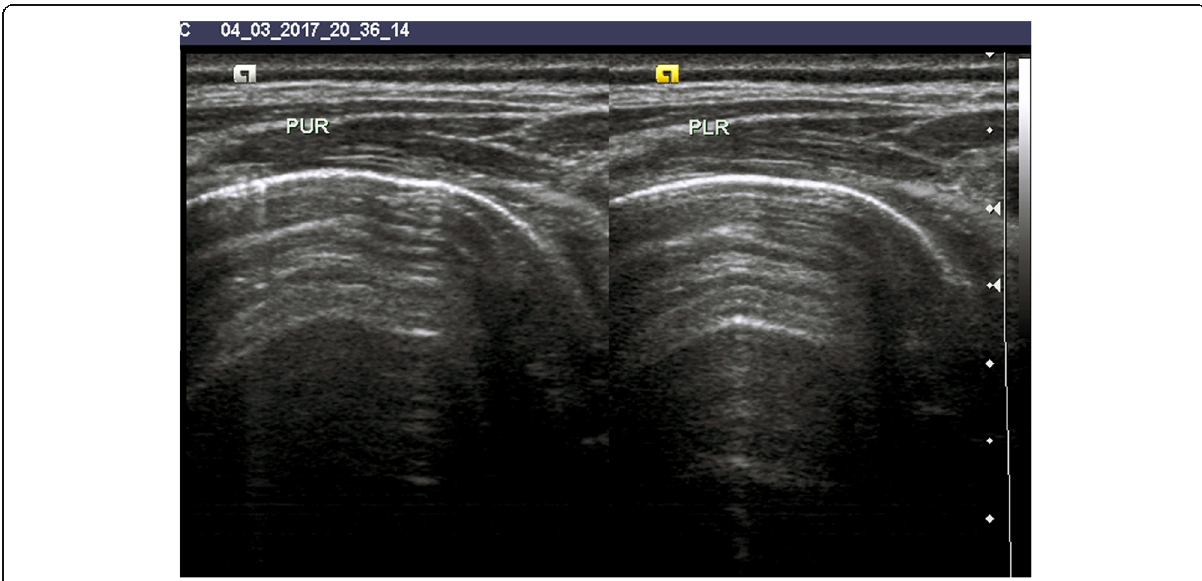
Fig. 5 B-mode ultrasound in the same patient before extubation and after switching to synchronized intermittent mechanical ventilation SIMV. Scanning of the posterior upper and lower zones of the right lung showed improvement of lung aeration with regain of normal A-lines giving a local score of 0. The total lung ultrasound score of the patient was 3, and the patient was successfully extubated